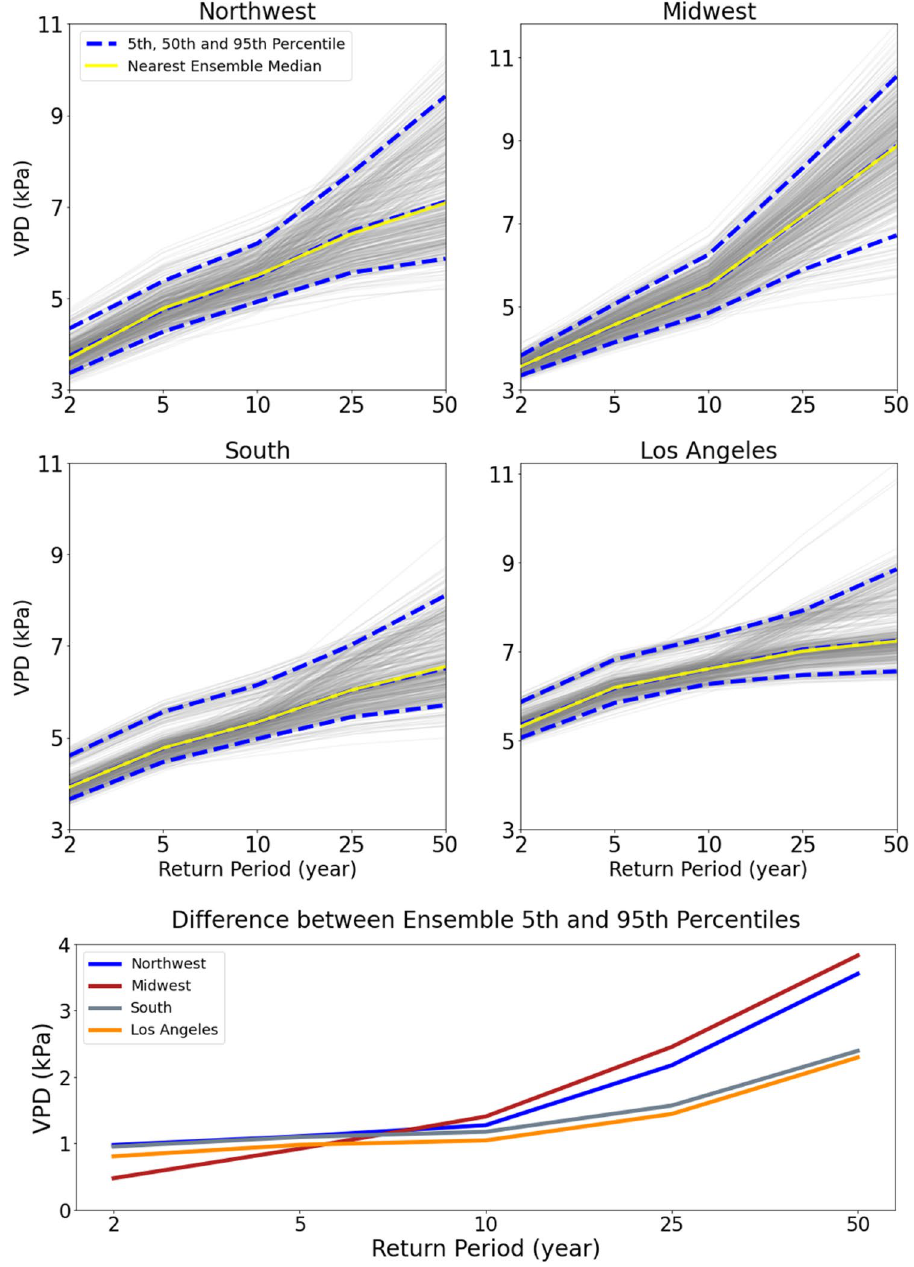
Figure 6. Ensemble return periods for the Northwest, Midwest, South and Los Angeles locations. Return periods for each sampled GEV fit is represented with grey lines, and the 5th, 50th, and 95th percentile of the model ensemble is represented with dashed blue lines. The yellow line is the nearest model to the ensemble median. The difference in ensemble 5th and 95th percentiles for each location are shown in the bottom